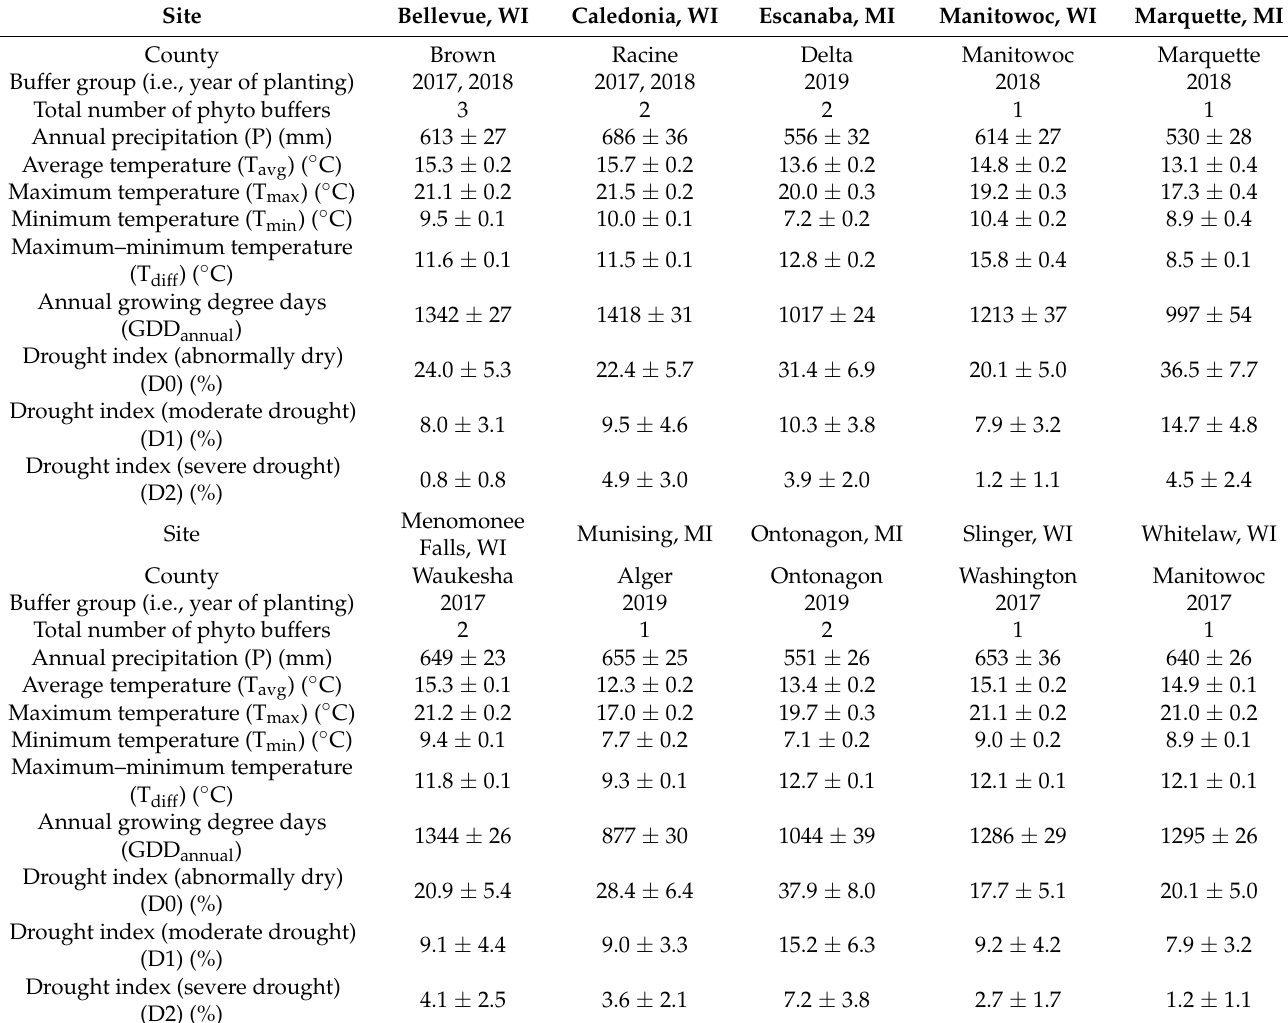
Table 1. Precipitation, temperature, growing degree days, and drought indices of ten field testing sites in a regional phyto technologies network consisting of sixteen phytoremediation buffer systems (i.e., phyto buffers) established from 2017 to 2019 in the Lake Superior watershed of the Upper Peninsula of Michigan, USA and the Lake Michigan watershed of eastern Wisconsin,